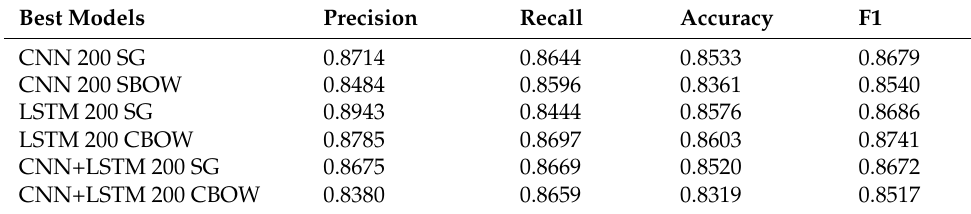
Table 7. Effectivity of the best